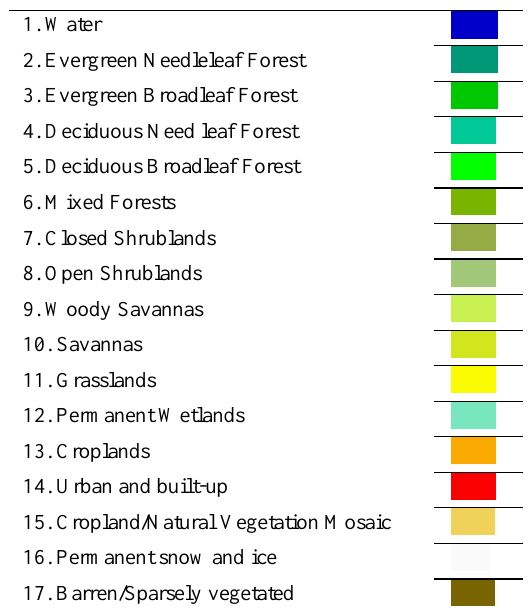
Table 1. Land cover categories(IGBP